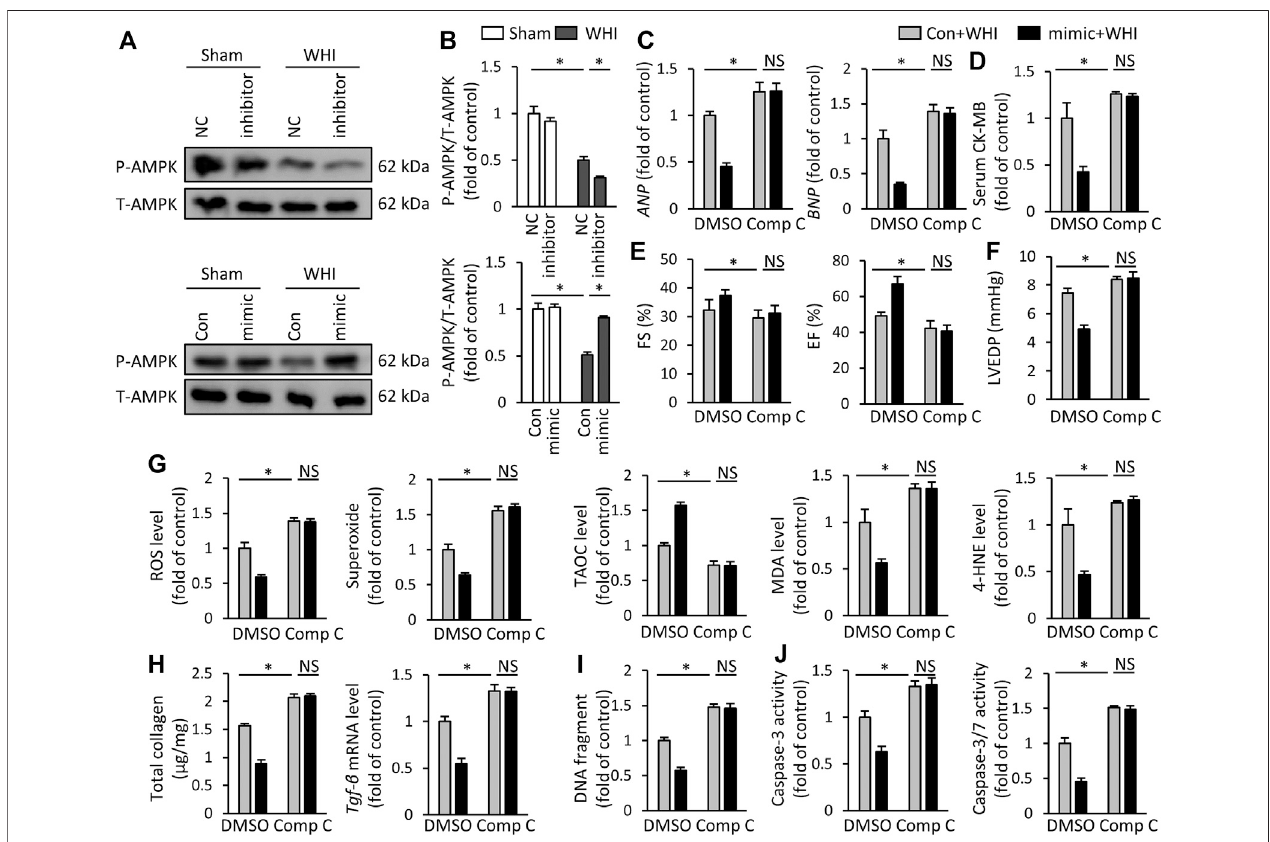
FIGURE 6 | miR-223-3p mimic improves WHI-induced RIHD by activating AMPK (A , B) Protein expression of total AMPK and phosphorylation AMPK ( n (cid:2) 6). (C) Relative mRNA levels of ANP and BNP ( n (cid:2) 6). (D) Serum CK-MB level ( n (cid:2) 6). (E , F) The alteration in FS, EF, and LVEDP in mice with or without compound C administration ( n (cid:2) 6). (G) ROS content and oxidative products in mice ( n (cid:2) 6). (H) Determination of the total collagen content and relative mRNA level of TGF- β ( n (cid:2) 6). (I) QuantitativeresultsofDNAfragments( n (cid:2) 6). (J) Quantitative resultsofcaspase-3activity andcaspase-3/7activity ( n (cid:2) 6). Alldataarepresented as means ± SD. * p < 0.05 vs. the matched